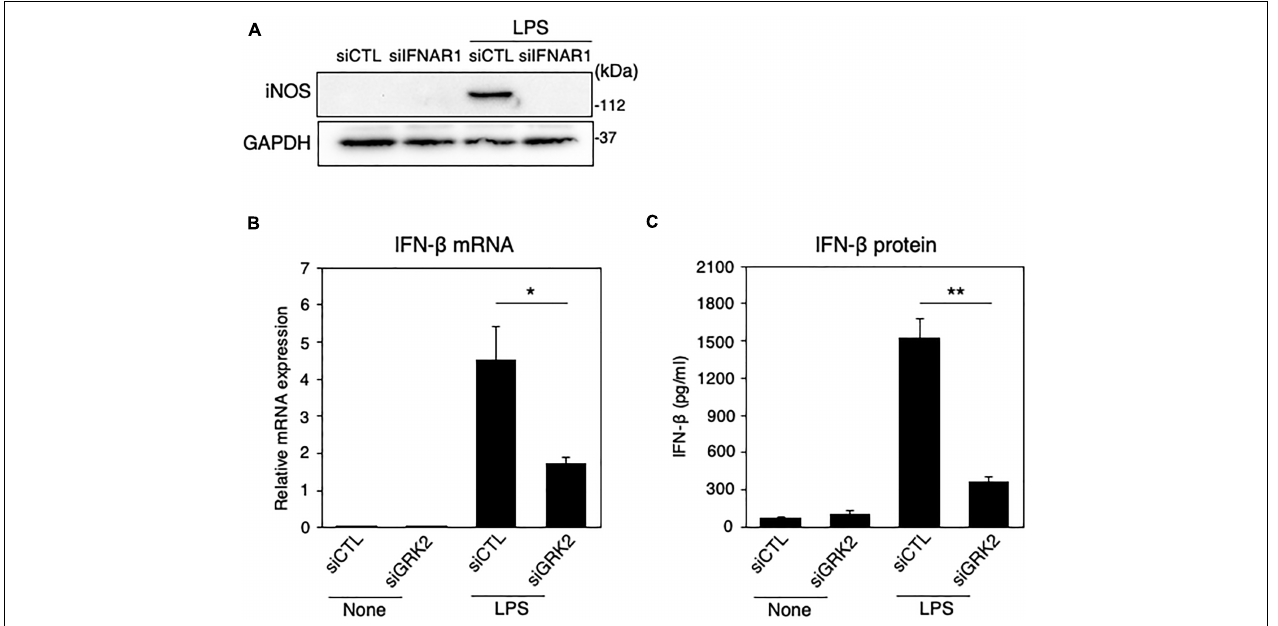
FIGURE 4 | Effect of GRK2 siRNA transfection on IFN- β expression in LPS-stimulated MG6 cells. (A) iNOS protein expression before and 15 h after 100 ng/ml LPS application in the presence of IFNAR1 siRNAs (siIFNAR1) or the negative control siRNAs (siCTL). GAPDH served as loading control. Shown are representative Western blots from three independent experiments in which the same results were obtained. (B) IFN- β mRNA expression levels. Following transfection of GRK2 siRNAs (siGRK2) or the negative control siRNAs (siCTL), cells were exposed to 100 ng/ml LPS for 3 h. The mRNA levels were expressed as a fold increase above control normalized GAPDH. (C) Cell culture media were collected 6 h after application of 100 ng/ml LPS, and the concentrations of IFN- β were measured by the ELISA. The results represent the mean ± SEM for three independent experiments. ∗ P < 0.05 and ∗∗ P < 0.01 by t -test.